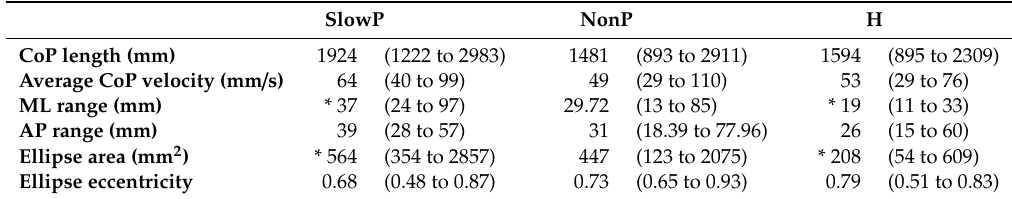
Table 2. Postural parameters during quiet stance. Data are shown as median value (range) for children with slow progressive PCA (SlowP), children with non-progressive PCA (NonP), and healthy children (H). ML: mediolateral; AP: anteroposterior; CoP: center of pressure. * Significant di ff erence between SlowP and H groups, Dunn test p < 0.05.